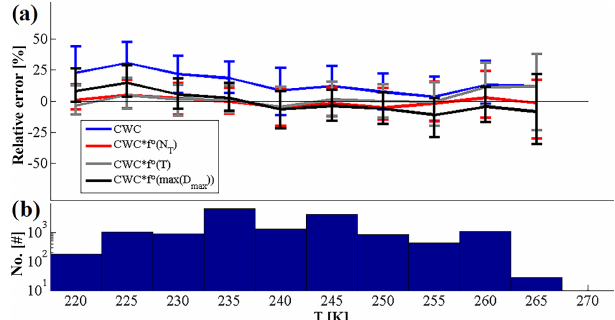
Figure 4. Same as Fig. 3, but represented as a function of tempera- ture T on the x axis.